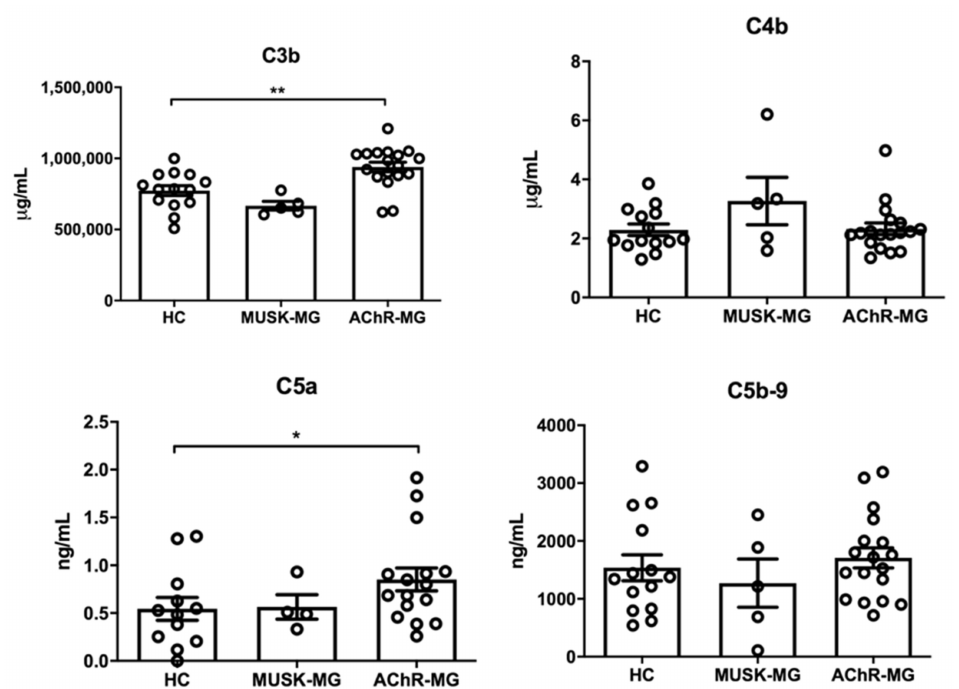
Figure 2. Quantification of complement activation products in plasma of healthy controls (HC), and MUSK-MG and AChR-MG patients. Protein concentrations of C3b and C4b were obtained by bead-based multiplex immunoassays on Luminex platform. C5a and C5b-9 levels were estimated by a specific ELISA. A significant increase in C3b (** p < 0.01) and C5a (* p < 0.05) levels was found in AChR-MG patients compared to HC. No difference in C4b and C5b-9 concentration was found among AChR-MG and MuSK-MG patients and HC ( p > 0.05). Data in the graphs correspond to mean concentration values ± standard error of the mean (SEM) obtained in each sample group.